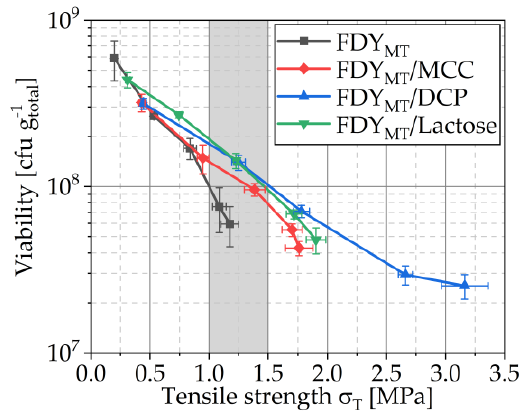
Figure 10. The relationship between viability and tensile strength. The target tensile strength interval (1.0–1.5 MPa) is highlighted. Symbols represent means and error bars standard deviation; n = 3.